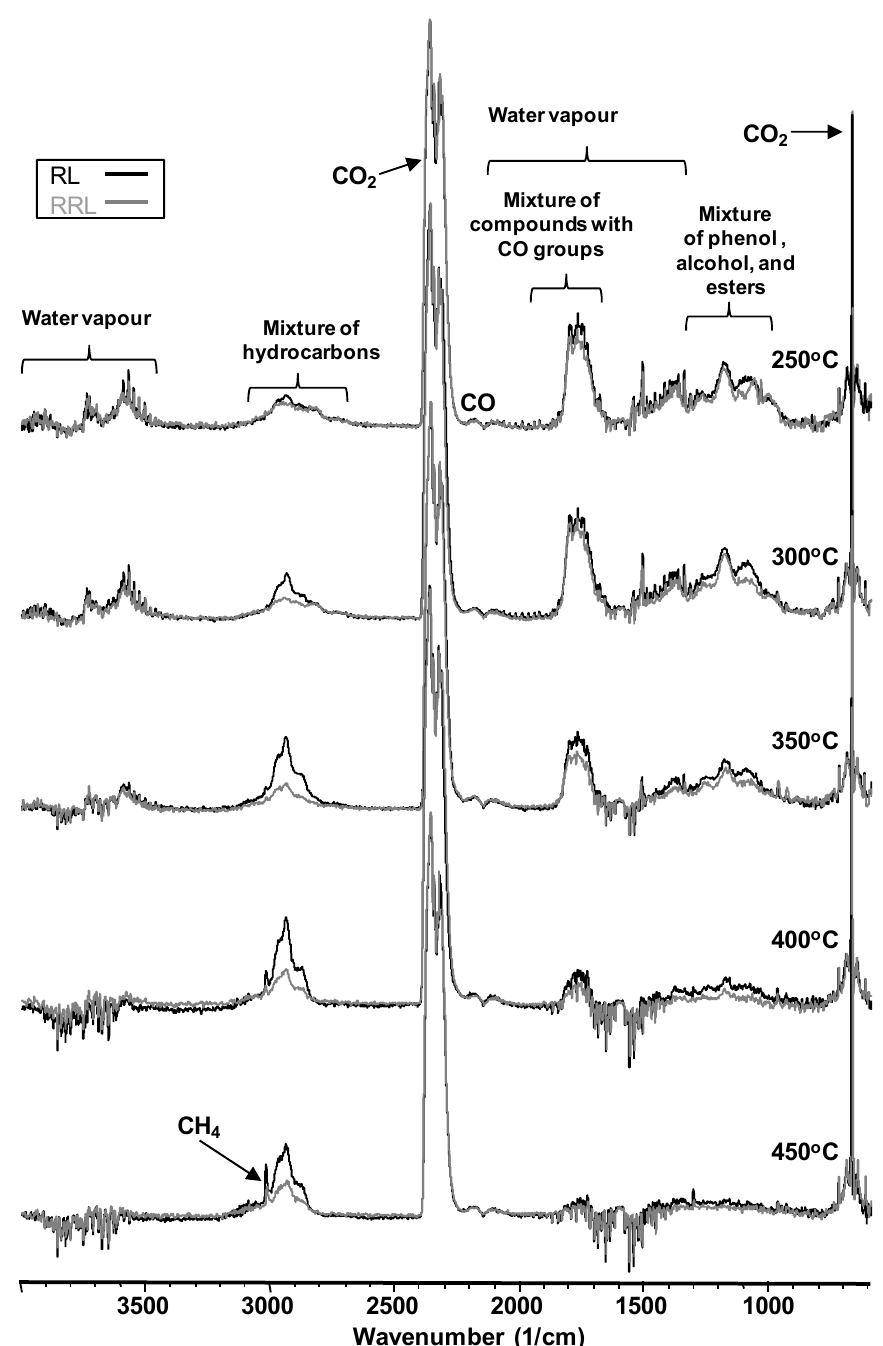
Figure 12. FT-IR spectra of volatile products emitted during pyrolysis of RL and RRL samples.